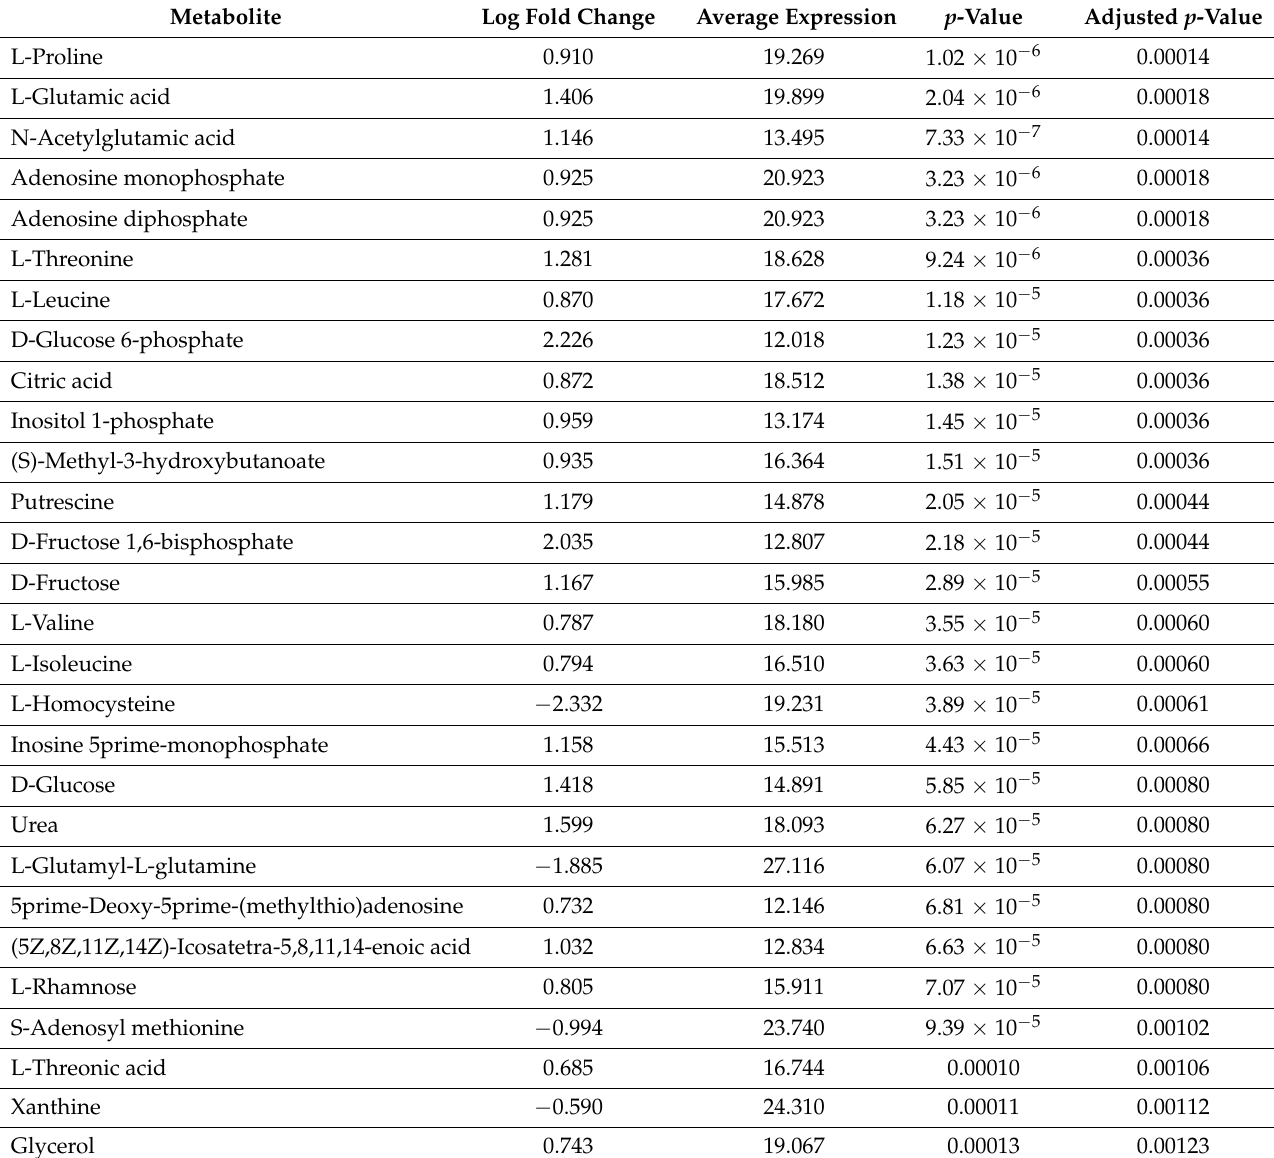
Table 2. List of the identified 101 metabolites that differ significantly between Mecp2 − /y and WT cortices (FDR ≤ 0.05). For each metabolite the common name, log2 fold change, raw p -value, and adjusted p -value are reported. Only those metabolites are listed that could be identified (annotated) unequivocally in the